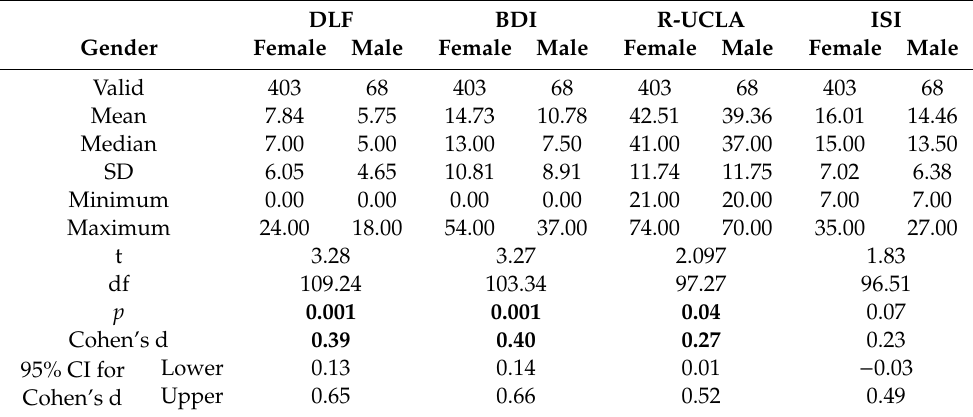
Table 3. Gender di ff erences for the Daily Life Fatigue scale (DLF), the Beck Depression Inventory (BDI), Revised UCLA Loneliness Scale (R-UCLA), and the Insomnia Severity Index (ISI) scales scores, n = 471. Confidence interval (CI). DLF BDI R-UCLA ISI Gender Female Male Female Male Female